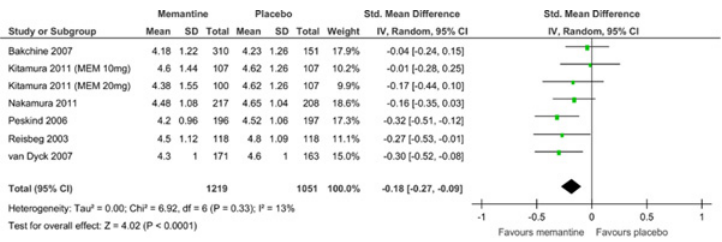
Fig 6. Forest plot of global function assessment (7 comparisons, n = 2270). * Negative SMD values favor memantine; positive SMD values favor placebo. † RR < 1 favors memantine; RR > 1 favors placebo.